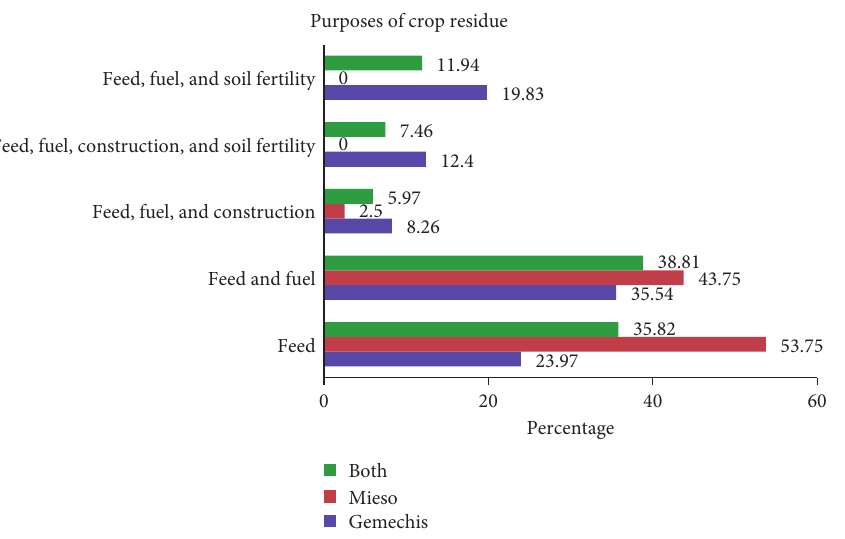
Figure 3: Purposes of crop residues. Source: survey result